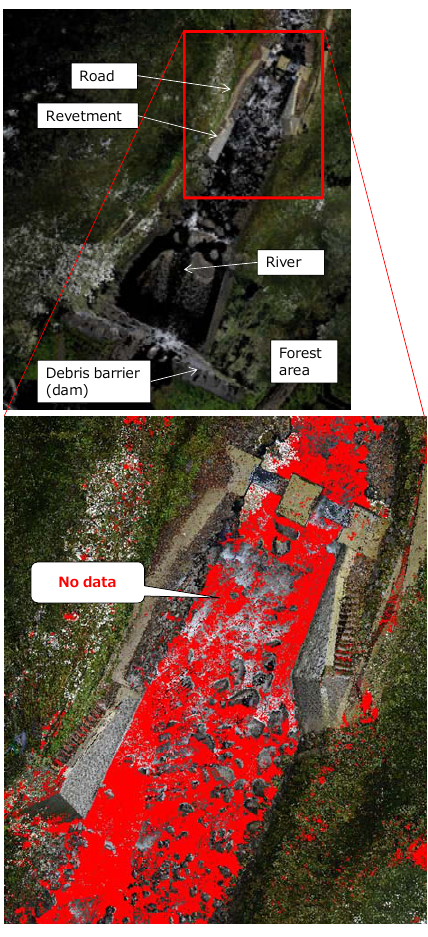
Figure 19. DEM generated point cloud